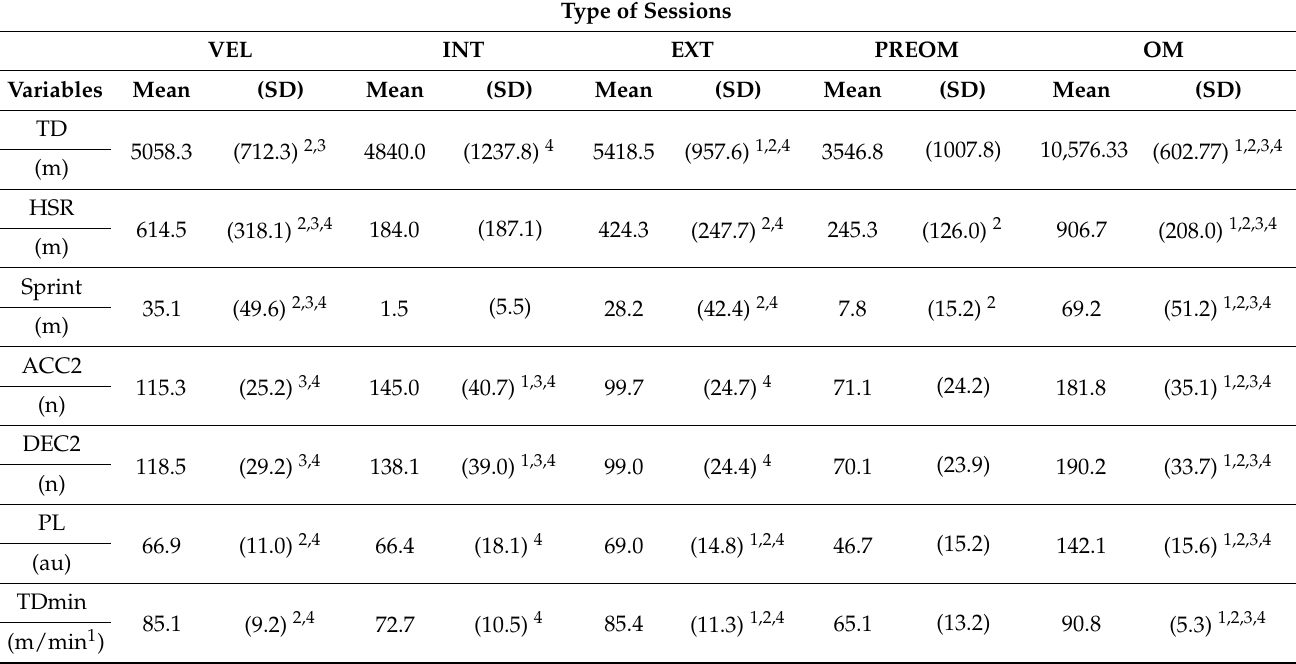
Table 1. Mean and standard deviation (SD) of the external load variables in different training and competition sessions. Type of